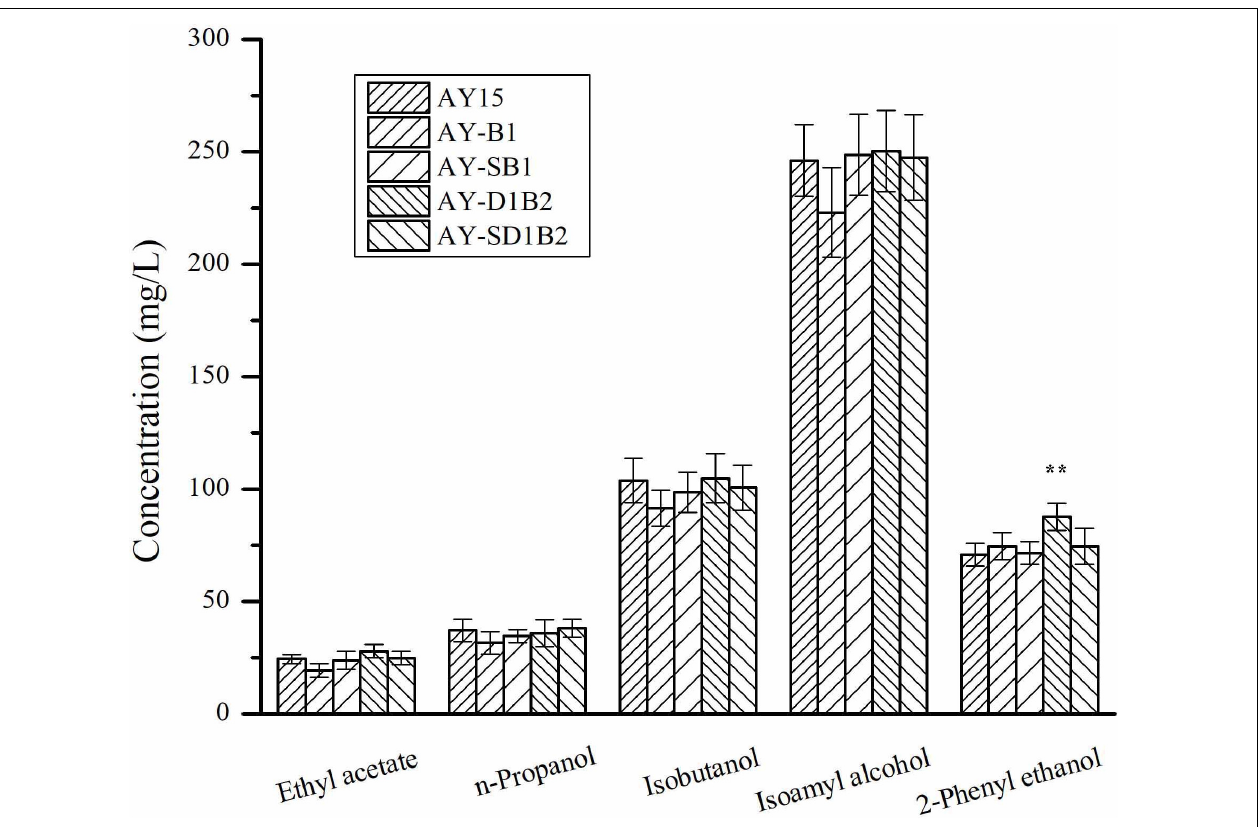
FIGURE 5 | The content of esters and higher alcohols in diploid strains. Data represent the mean of three independent biological replicates. Error bars represent the SD of the average values. Statistical significance is denoted as ** P < 0.01 and ** P <